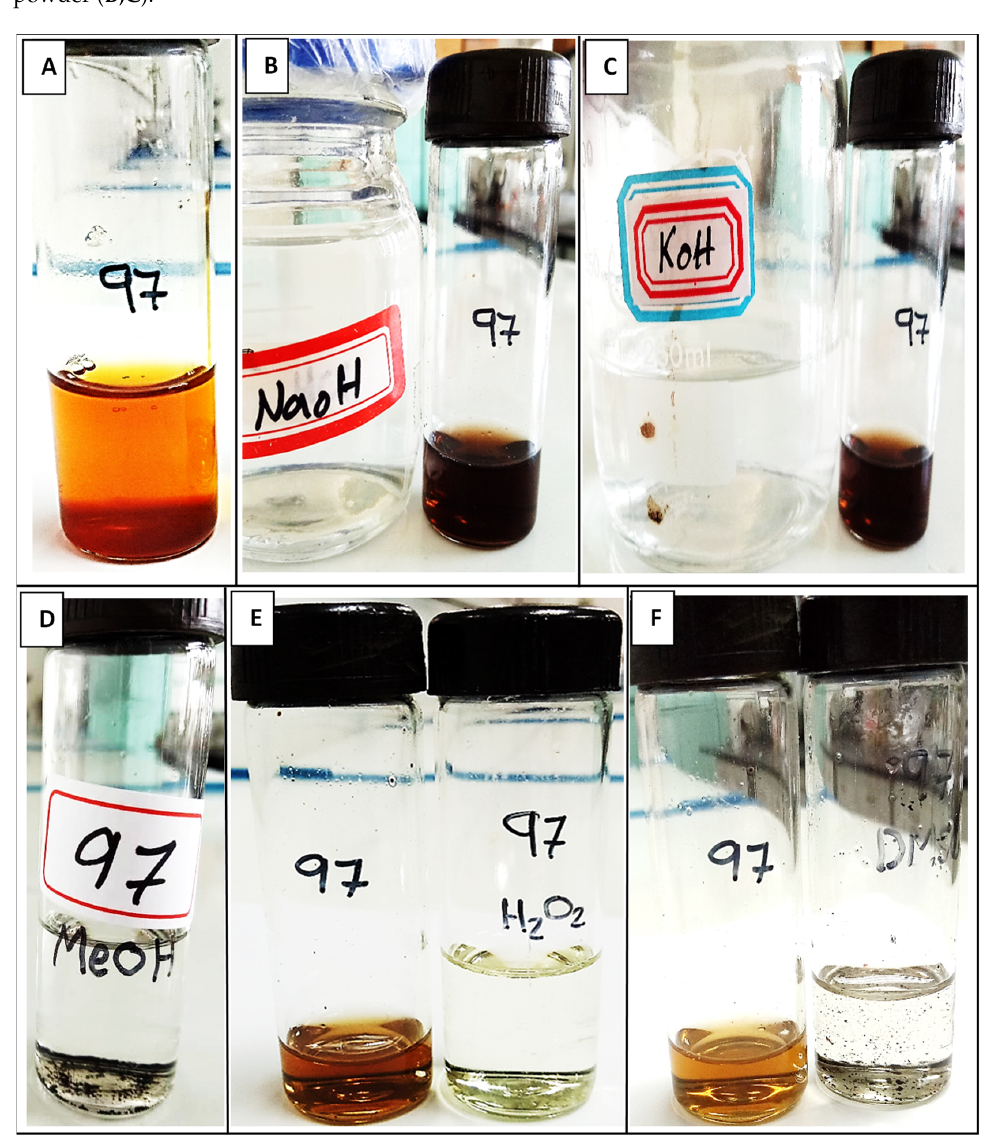
Figure 3. The solubility tests of extracted melanin from G. oxydans FBFS 97. A brown precipitate formed during the FeCl 3 test ( A ), solubility test in 1 mol/L NaOH ( B ), solubility test in 1 mol/L KOH ( C ), solubility in MeOH ( D ), H 2 O 2 decolorization test ( E ), solubility in DMSO ( F ).